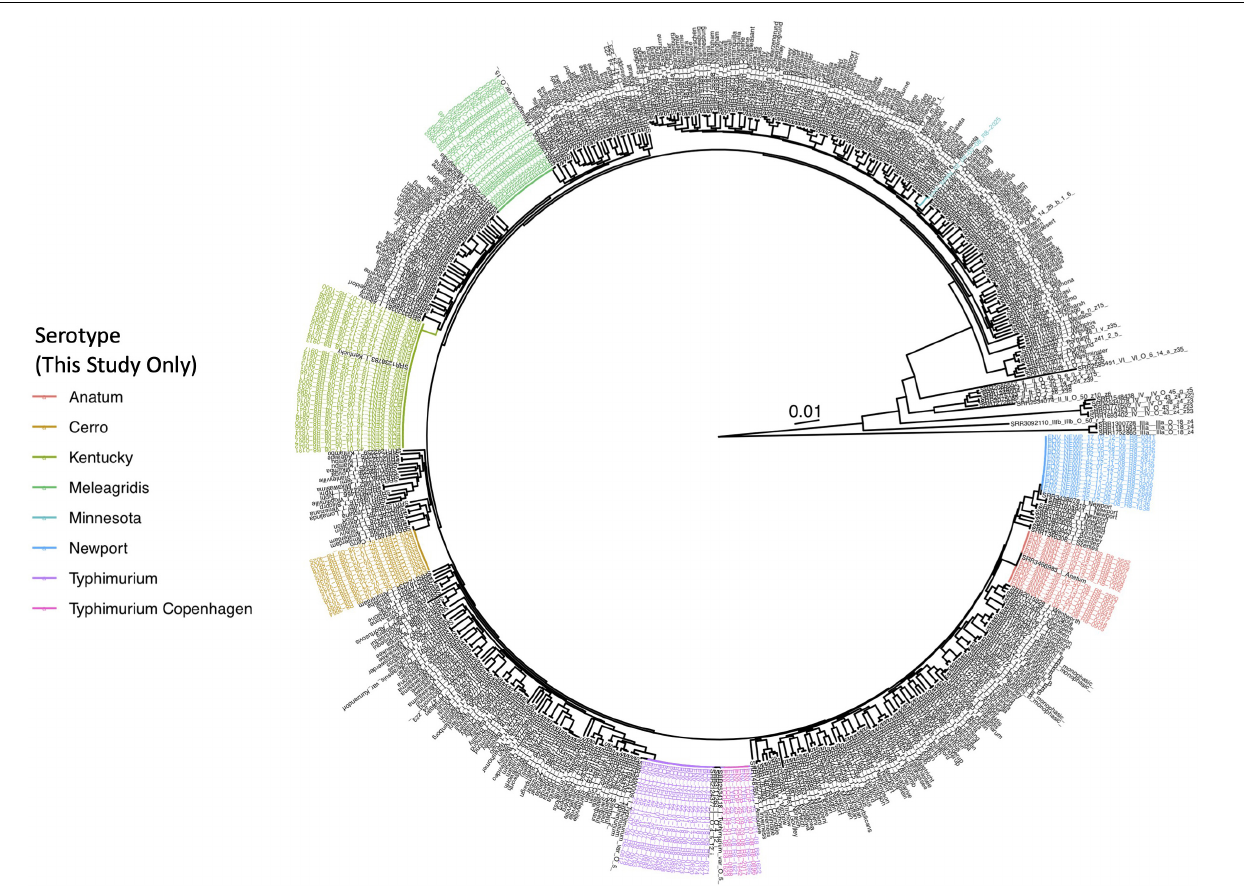
FIGURE 1 | Maximum likelihood phylogeny constructed using core SNPs identified among 570 Salmonella isolate genomes. Publicly available genomes are denoted by black tip labels ( n = 442), while genomes of bovine- and bovine farm-associated strains isolated in conjunction with this study are denoted by colored tip labels ( n = 128). In cases where a discrepancy existed between the traditional serotype designation of an isolate and one or more in silico methods (i.e., SISTR and SeqSero2), the serotype assigned using two out of the three methods was selected as the final serotype to be used for phylogeny annotation. The phylogeny is rooted at the midpoint with branch lengths reported in substitutions per site. Core SNPs were identified among all genomes using kSNP3, while the phylogeny was constructed and annotated using IQ-TREE and bactaxR/ggtree,